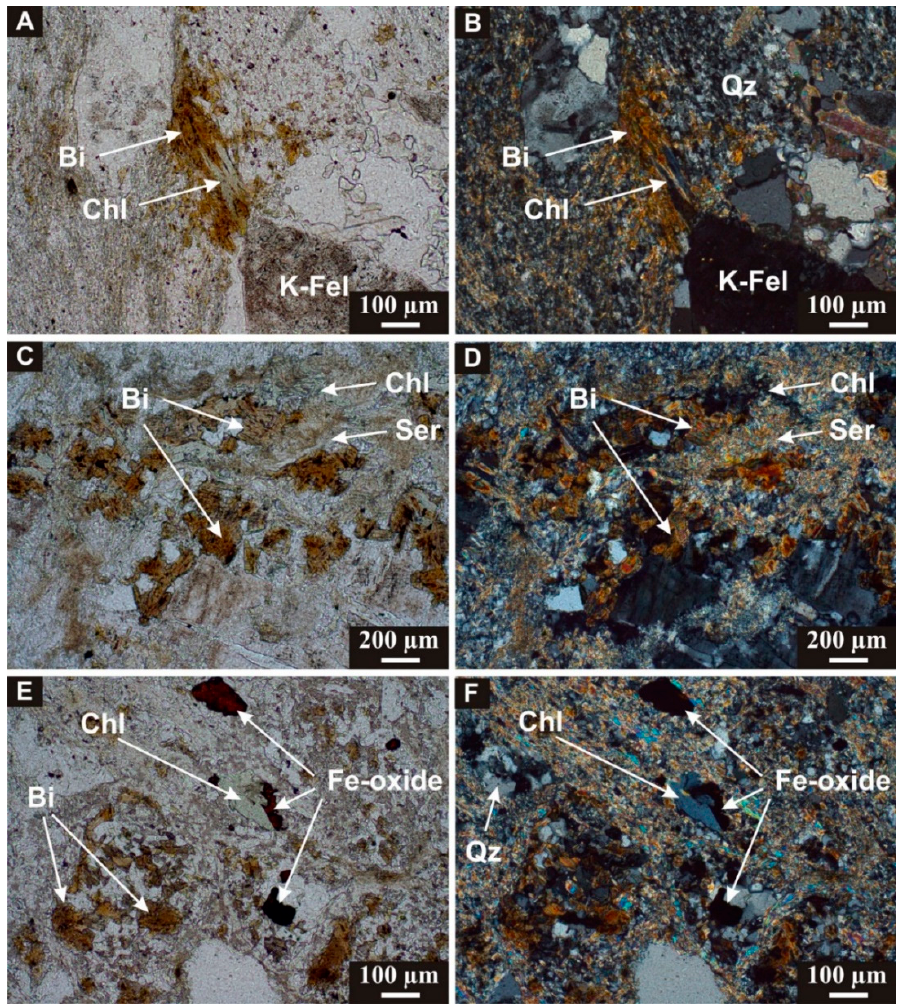
Figure 6. Photomicrographs showing textural relationships indicative of biotite alteration to chlorite; ( A , B ) 95-LPA-23 at 580 m, ( C , D ) HN-99-119 at 629 m, ( E , F ) alteration of iron-oxide to chlorite (95-LPA-10 at 239 m). Photo-micrographs (aA), (C) and (E) are in plain-polarized light, whereas (B), (D) and (F) are under crossed-polarized light.